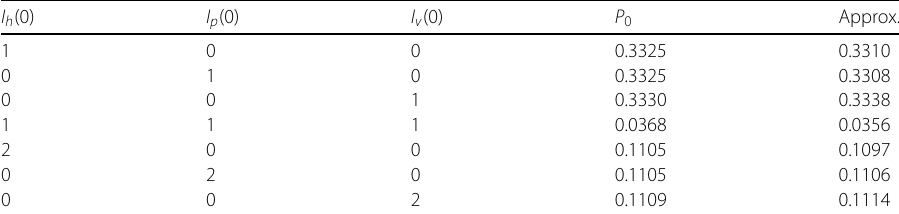
Table 4 Probability of disease extinction P 0 and results of numerical approximation (Approx.) using 10,000 sample paths of the CTMC model for parameter values taken from Table 3.